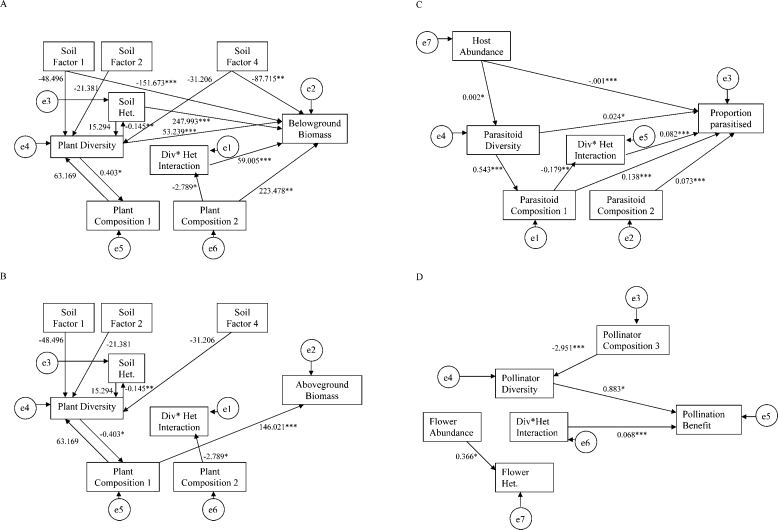
Final Most Parsimonious Structural Equation Models Relating Biodiversity, Resource Heterogeneity, Species Composition, Resource Abundance, and Ecosystem FunctionFunctions shown are: (A) belowground plant biomass, (B) aboveground plant biomass, (C) parasitism rates, and (D) pollination. All paths in the original models (Figures S1–S4) were treated as optional, and were thus able to be removed during model simplification using maximum likelihood estimation. As a final model we selected the model with a subset of the parameters in the initial model that included at least one predictor of function (plant biomass, parasitism, or pollination, respectively), and had the lowest AIC score. Values adjacent to paths indicate unstandardized direct effects, with significance indicated by *, p < 0.05; **, p < 0.01; ***, p < 0.001. For each original and final model, Cmin, AIC, and BCC scores, along with unstandardized and standardized total effects for final models are presented in Text S4.